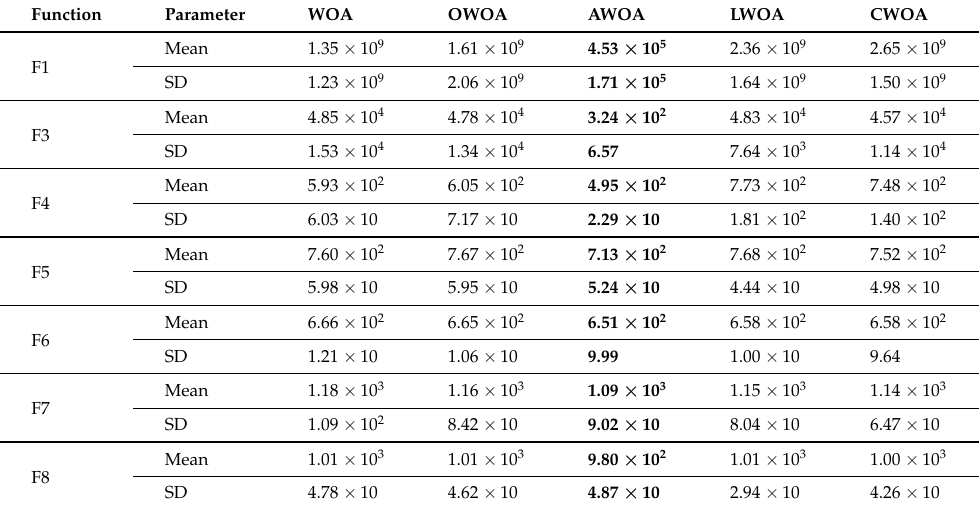
Table 6. Results of Benchmark Suite-2